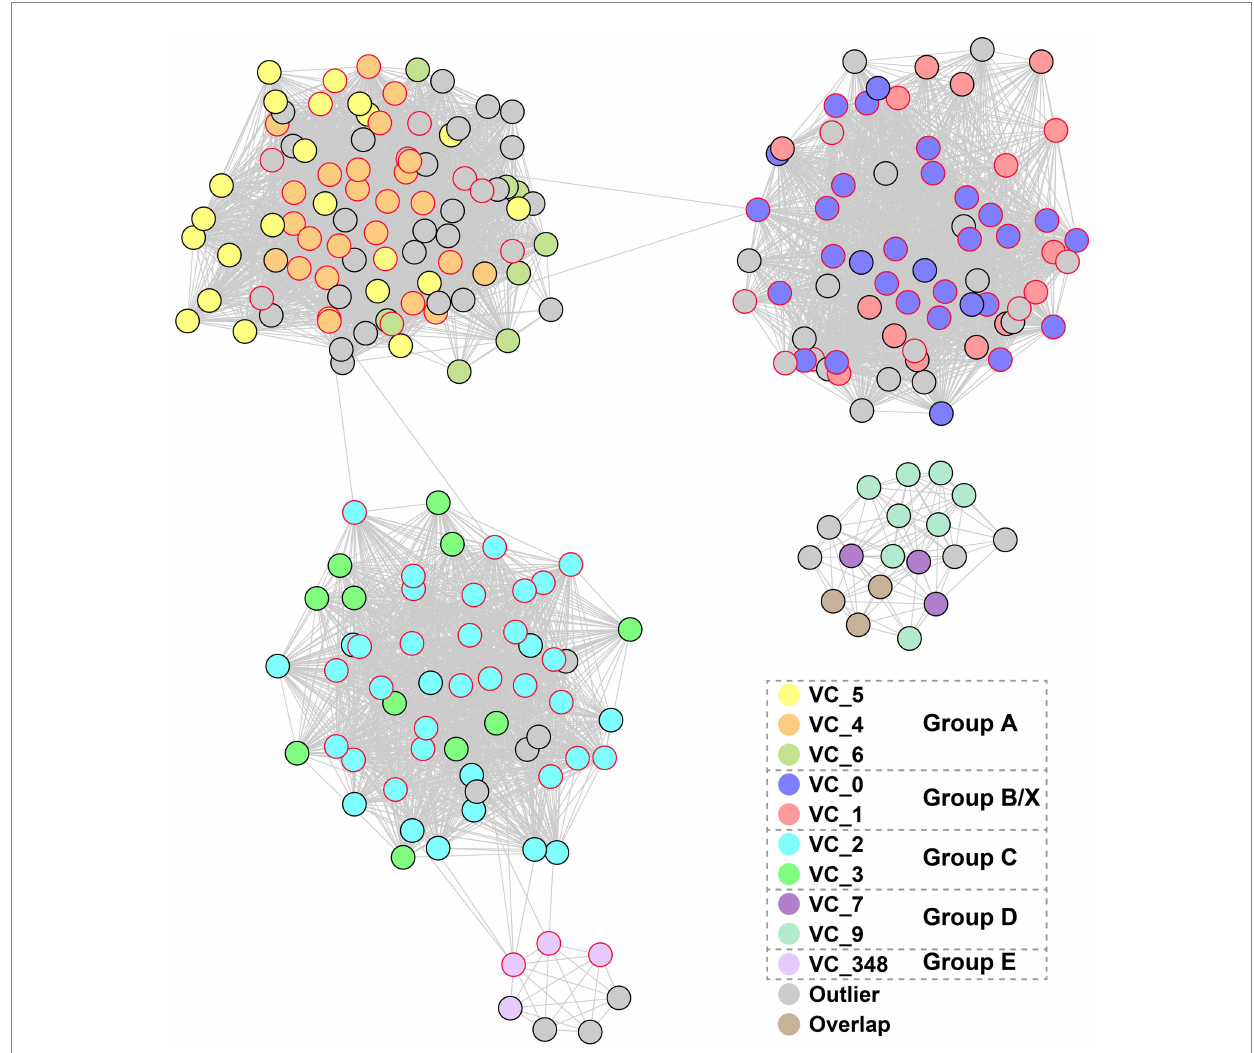
FIGURE 2 The network-based analysis of PCs shared among magroviral vOTUs. The nodes represent vOTUs, and the edges represent the strength of connectivity between each genome based on shared